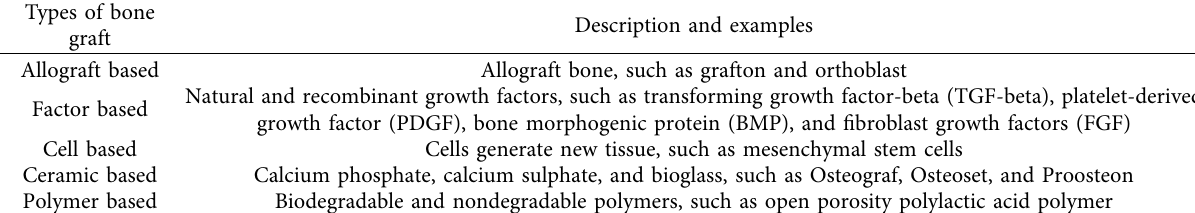
Table 1: Classification of bone grafts based on the composition.